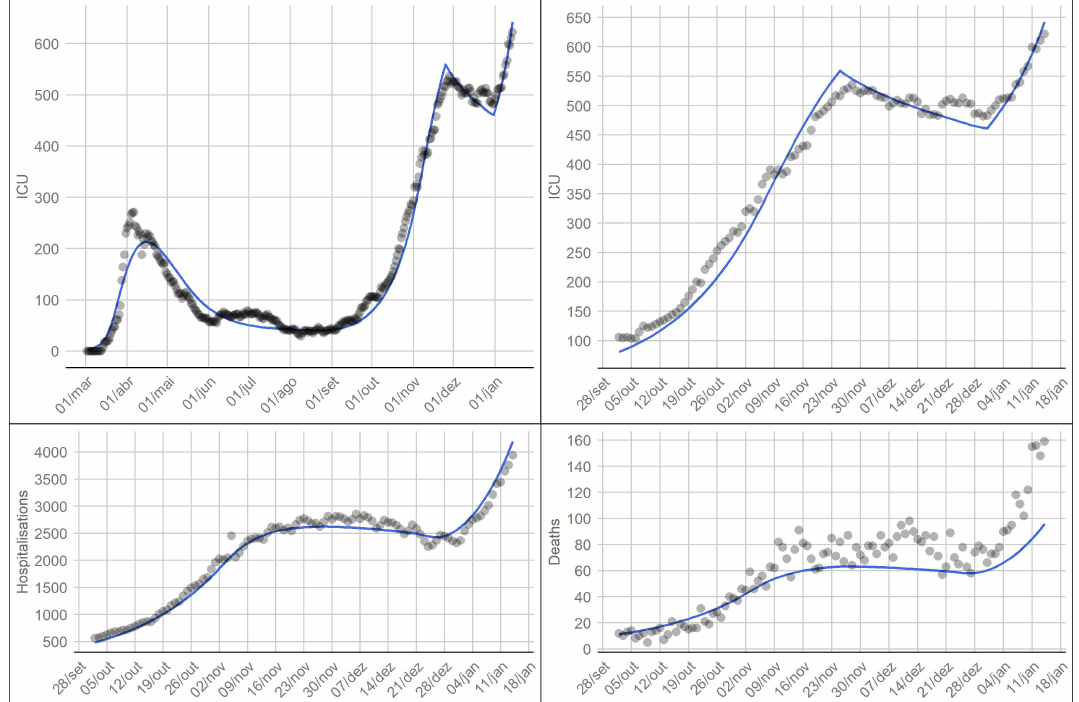
Figure 3. Model fit to ICU data since the start of the epidemic ( top left ). Model fit to ICU data from the 1st of October 2020 to the 15th of January 2021 ( top right ). Observed and model values for hospitalised individuals ( bottom left ) and deaths ( bottom right ). Solid lines represent the model, the dots represent observed values (data available in